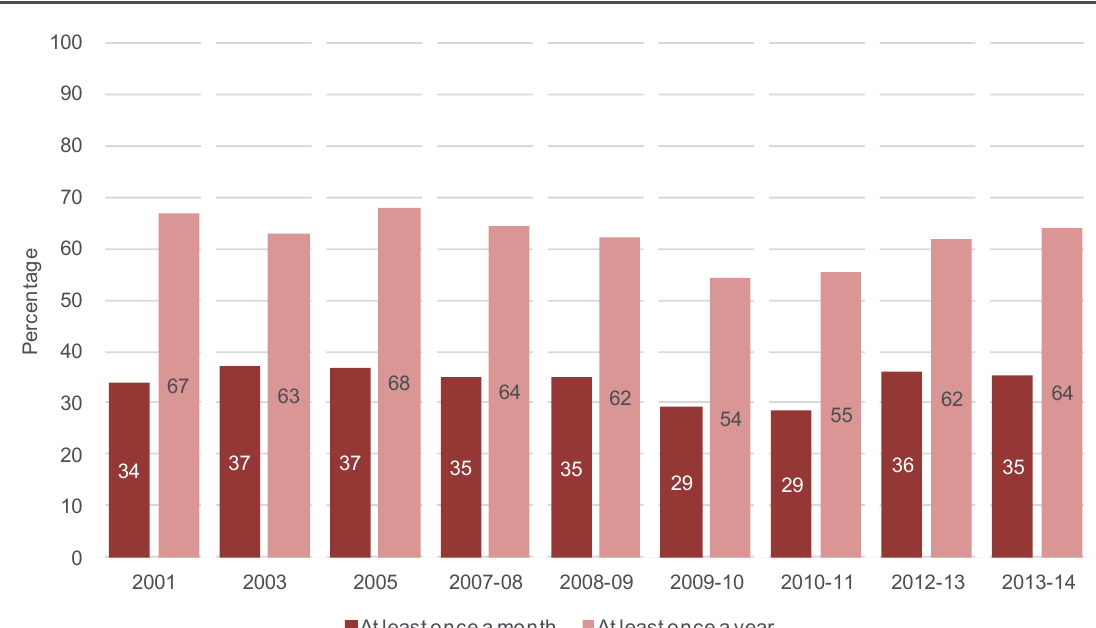
Figure 2: Whether people had participated in informal volunteering, 2001 to